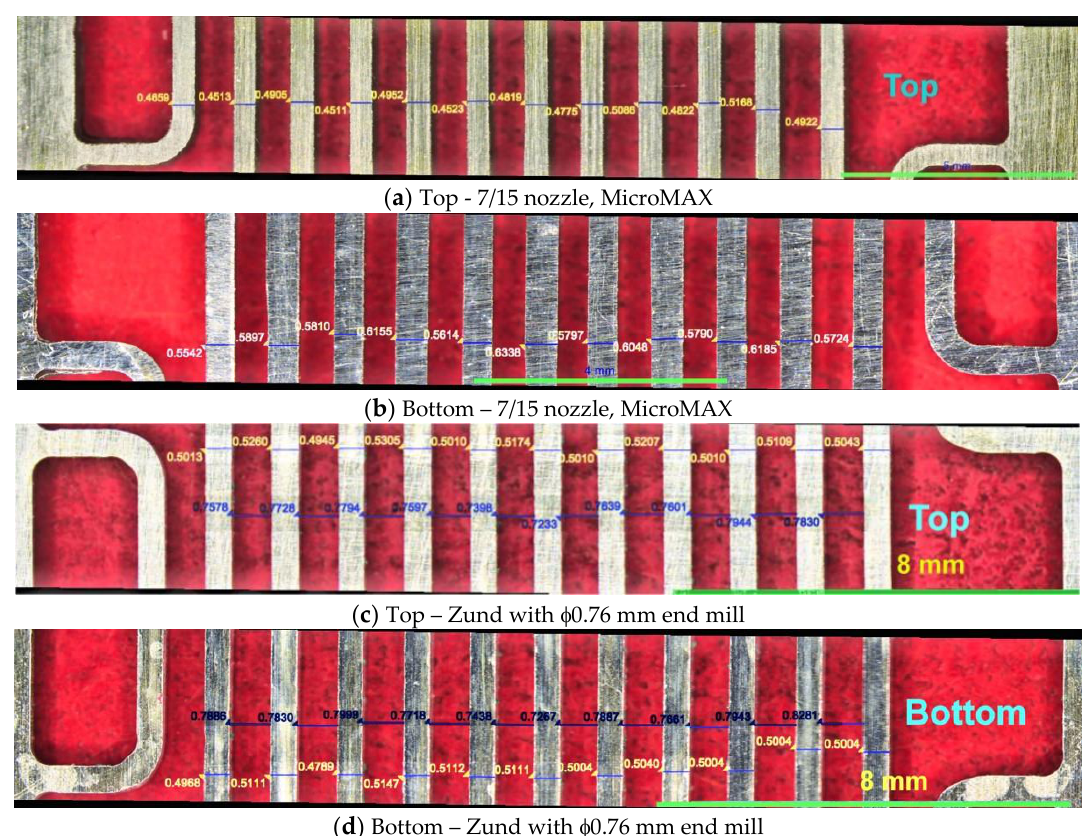
Figure 15. Width of flexure elements measured from micrographs.